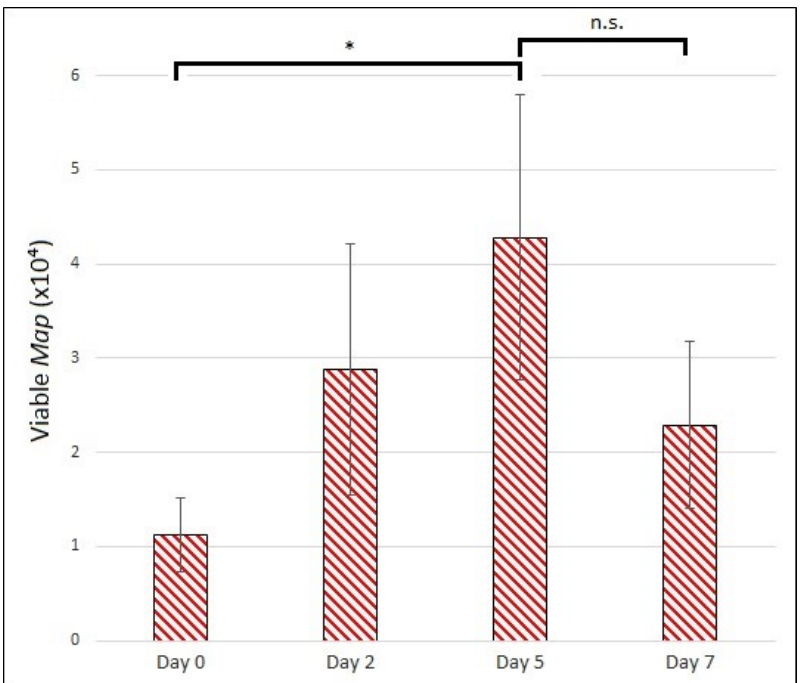
Figure 7. Enumeration of viable, internalized Map from in vitro granuloma model. Viable Map bacilli harvested and quantified on days 0, 2, 5, and 7 p.i. MOI of 1:4. The bars are standard deviation. *, p < 0.05; n.s. = not significant by student’s t-test (n = 3).